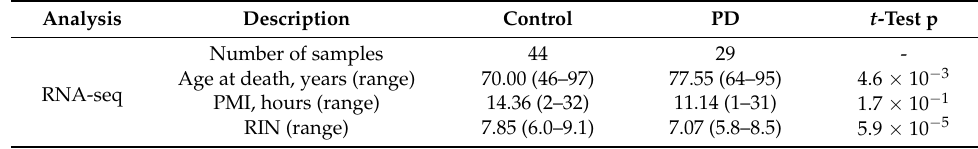
Table 1. Summarized statistics on RNA-seq by A. Dumitriu et al. [38]. Analysis